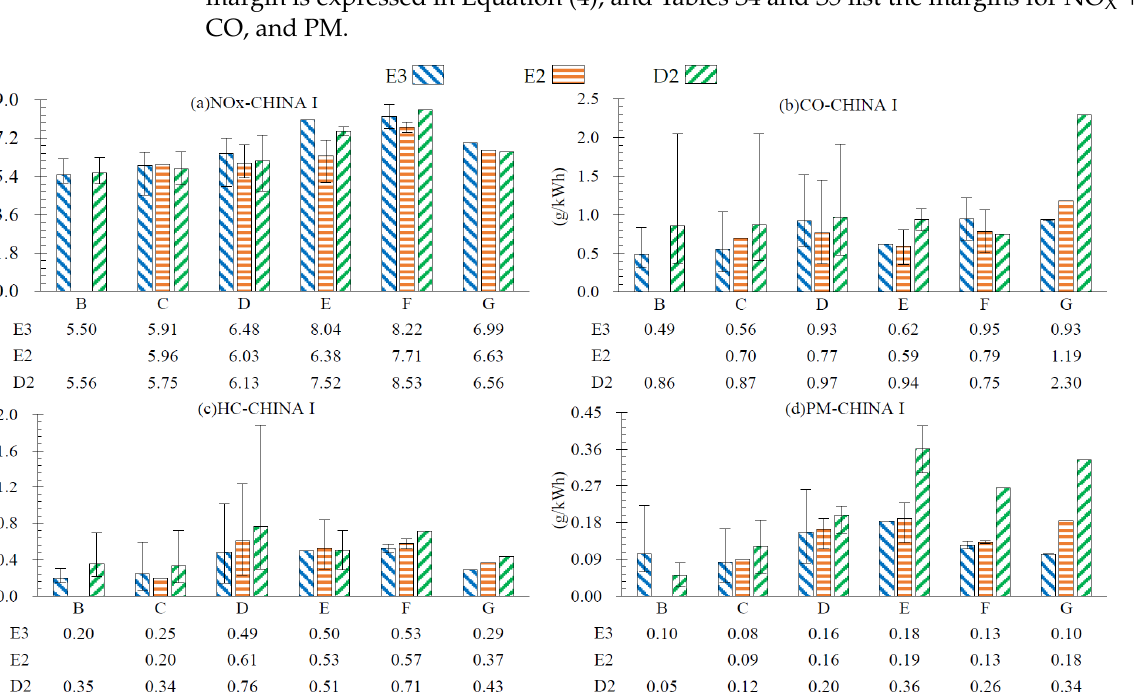
Figure 3. Fuel-based emission factors for different single-cylinder displacements under the CHINA II standard. ( a ) NOx-specific emissions in the E3, E2, and D2 cycles; ( b ) CO-specific emissions in the E3, E2, and D2 cycles; ( c ) HC-specific emissions in the E3, E2, and D2 cycles; ( d ) CO 2 -specific emis- sions in the E3, E2, and D2 cycles.